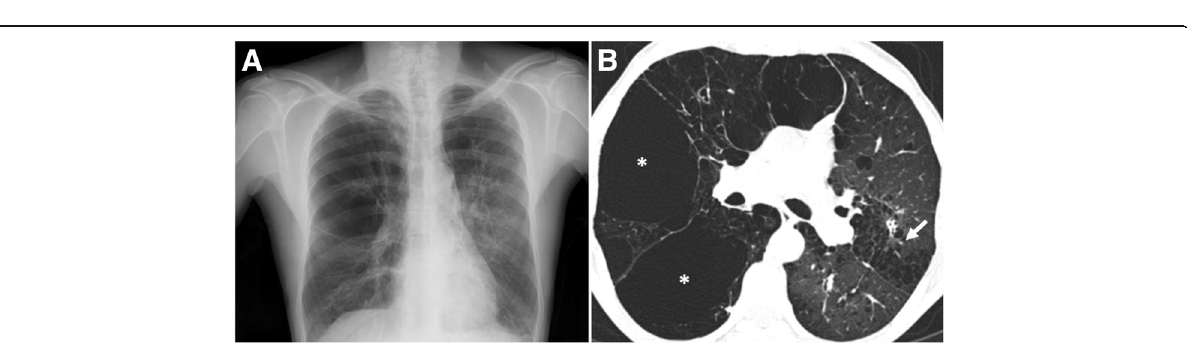
Fig. 8 Bullous emphysema in a 55-year-old man. a Posteroanterior (PA) radiograph shows lucencies in the superior half of the right hemithorax and in the upper left hemithorax. b Axial CT shows upper lobe predominant bullae (asterisks) in the subpleural surface of the right lung. Moderate CLE is also present (arrow)